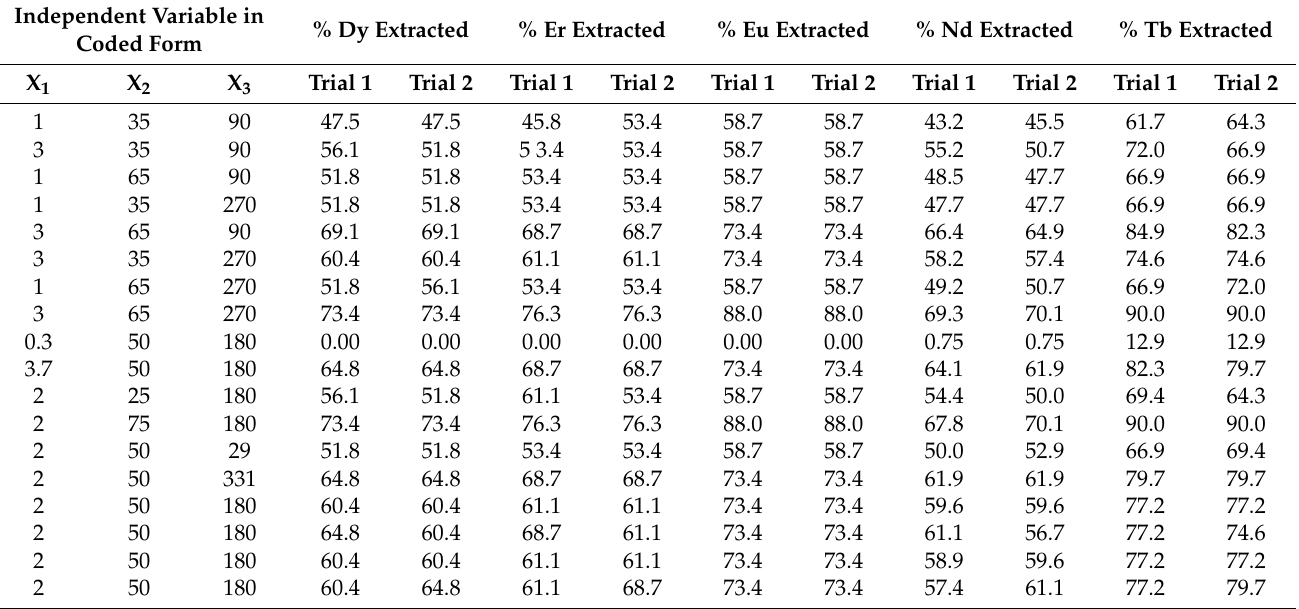
Table 4. Percent extraction of Dy, Er, Eu, Nd and Tb corresponding to each combination of indepen- dent variables.